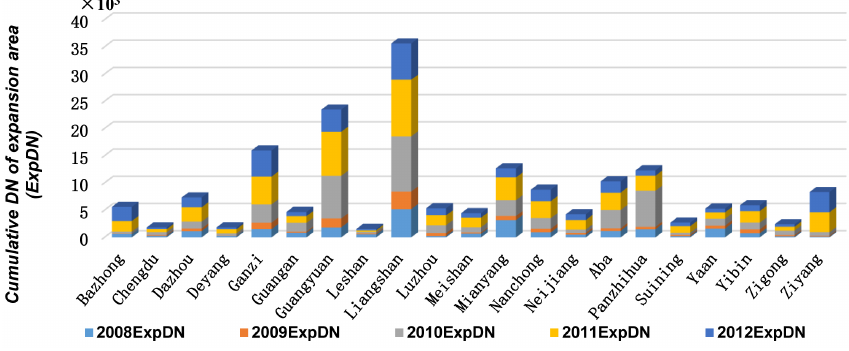
Figure 11. The cumulative DN of the expansion area.